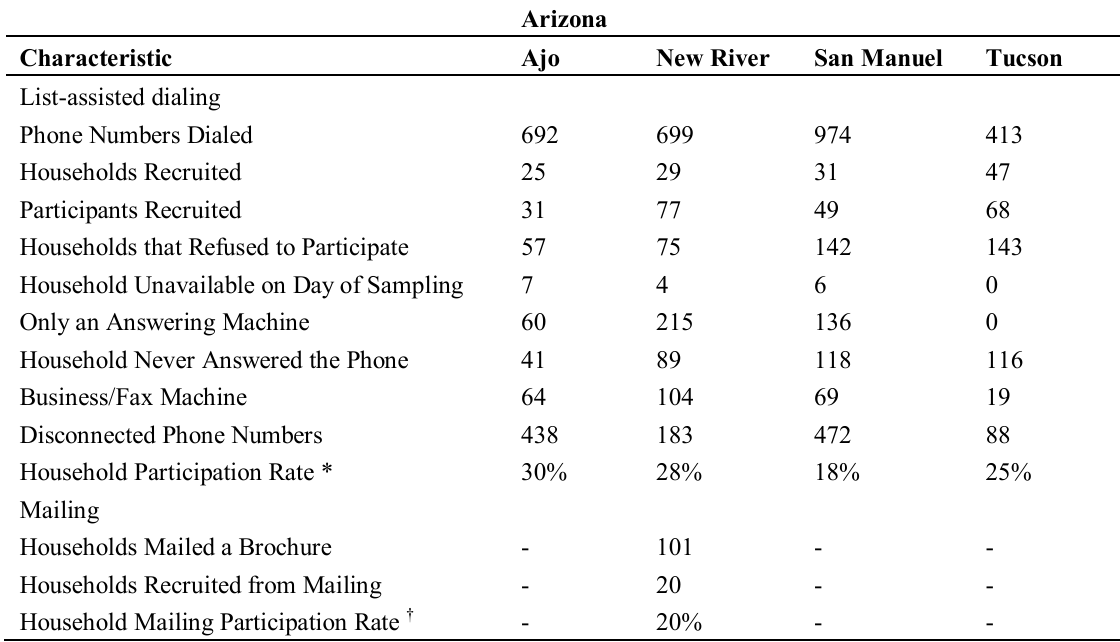
Table 1. Household Participation Rates among Arizona Residents by Location.